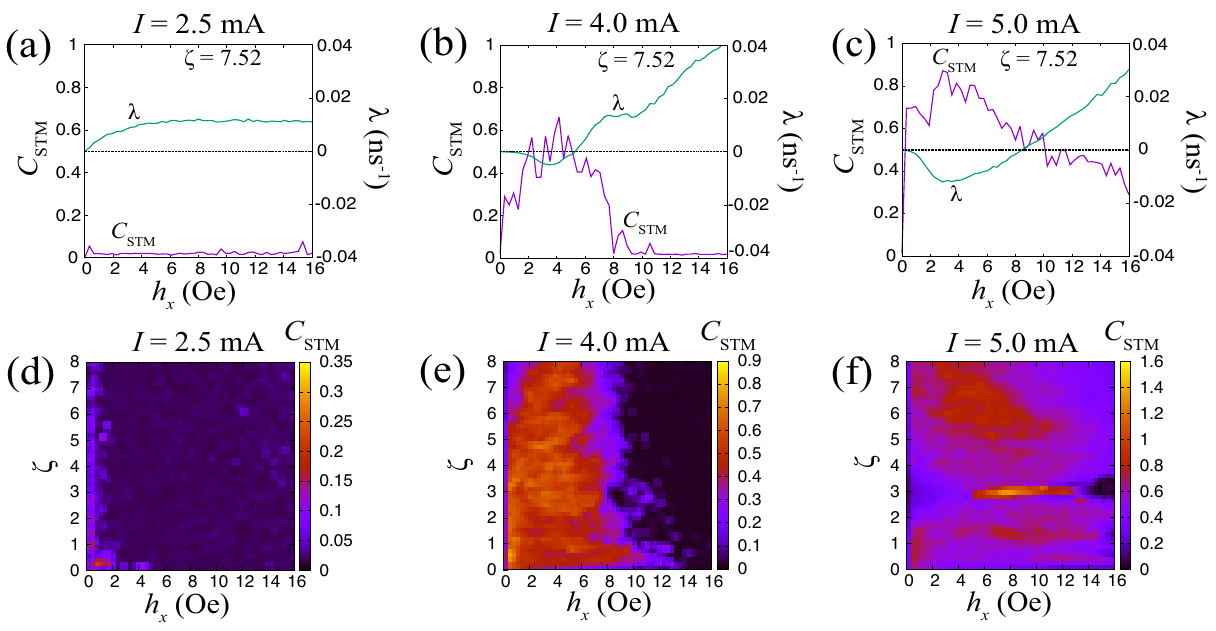
Figure 4. Dependence of short-term memory capacity ( C STM ) and the Lyapunov exponent (cid:31) on the input strength h x for currents I of ( a ) 2.5, ( b ) 4.0, and ( c ) 5.0 mA; here ζ = 7.52 . Dependence of C STM and h x on h x and ζ for currents of ( d ) 2.5, ( e ) 4.0, and ( f ) 5.0